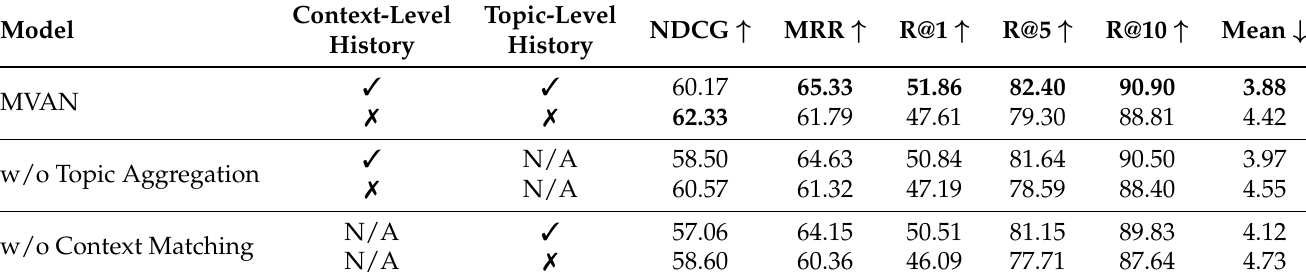
Table 4. Ablations of our approaches on the VisDial v1.0 validation